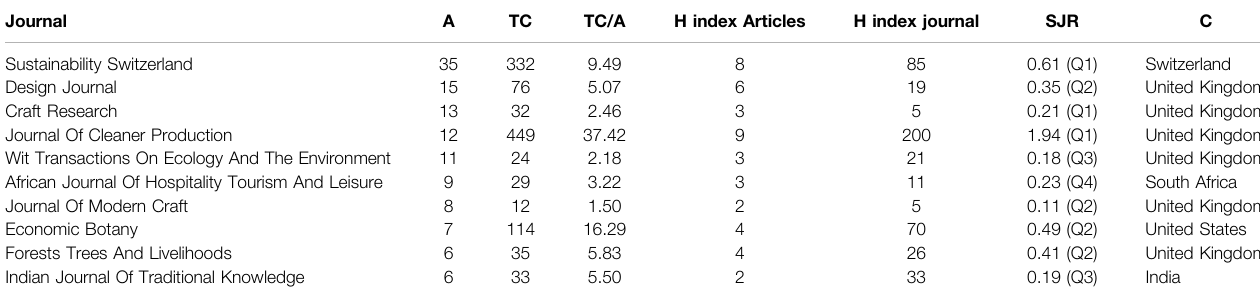
TABLE 6 | Top 10 most productive journals in sustainable crafts. Source: Authors ’ own. Journal